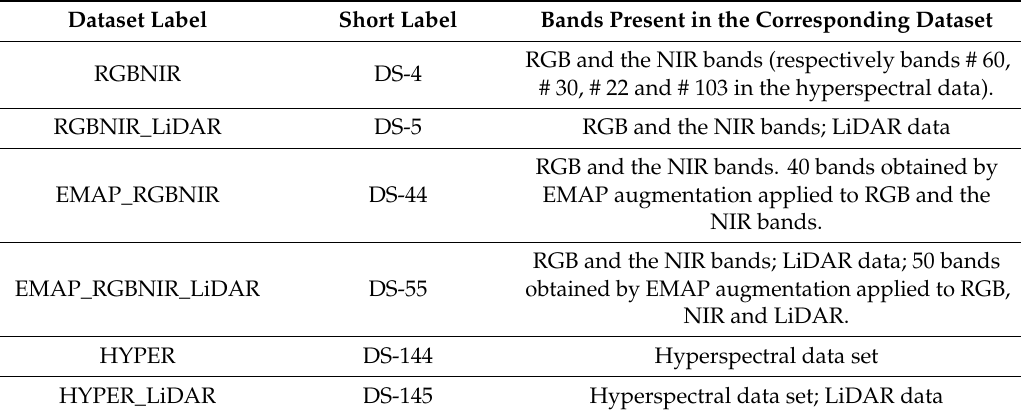
Table 2. Dataset labels and the corresponding bands.